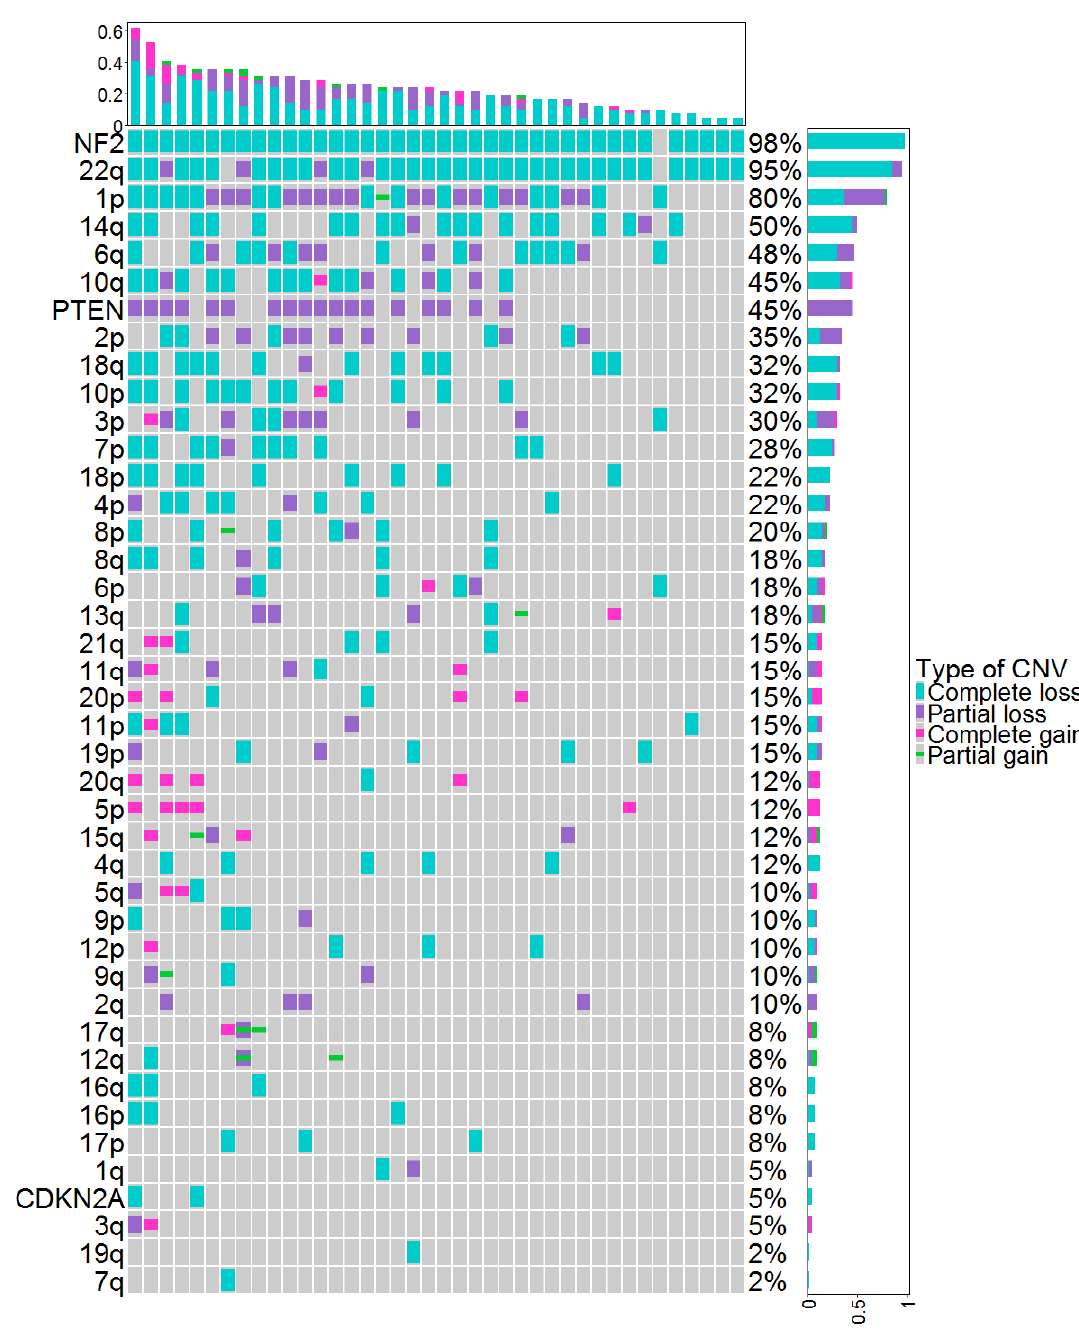
Figure 1. CNVs identified by DNAm in the cohort of 48 meningiomas. Each column represents individual patients ordered from left to right by increasing frequency of genetic alterations. Genetic alterations are ordered on the y axis from top to bottom by decreasing frequency of genetic alterations. CNV: copy-number variation, DNAm: DNA methylation.